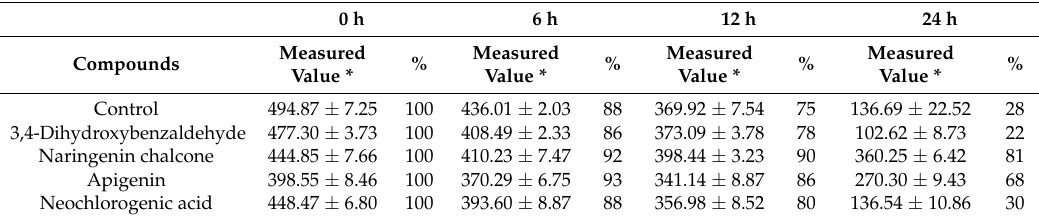
Table 3. Results of the scratch test for PC3